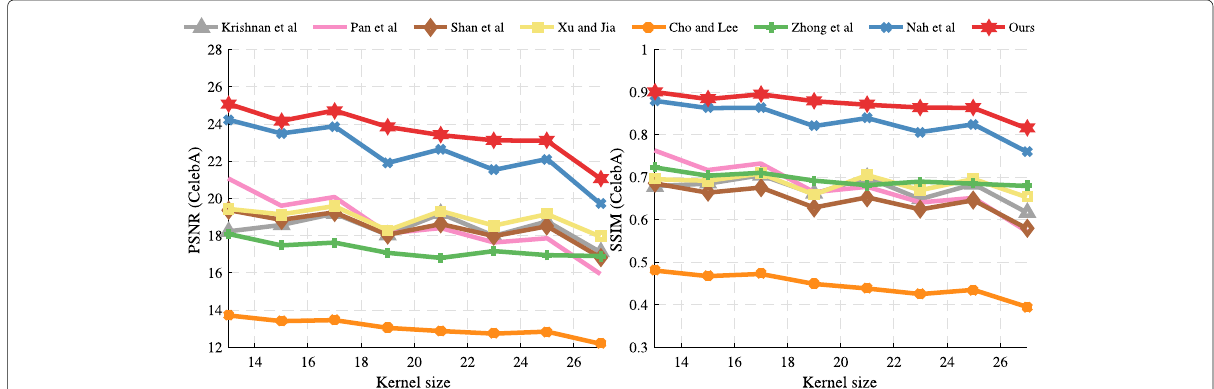
Fig. 7 Quantitative evaluation on CelebA dataset. Here, we choose 100 clear images from CelabA dataset and convolute these images with 80 blur kernels to generate 8000 blurred images for